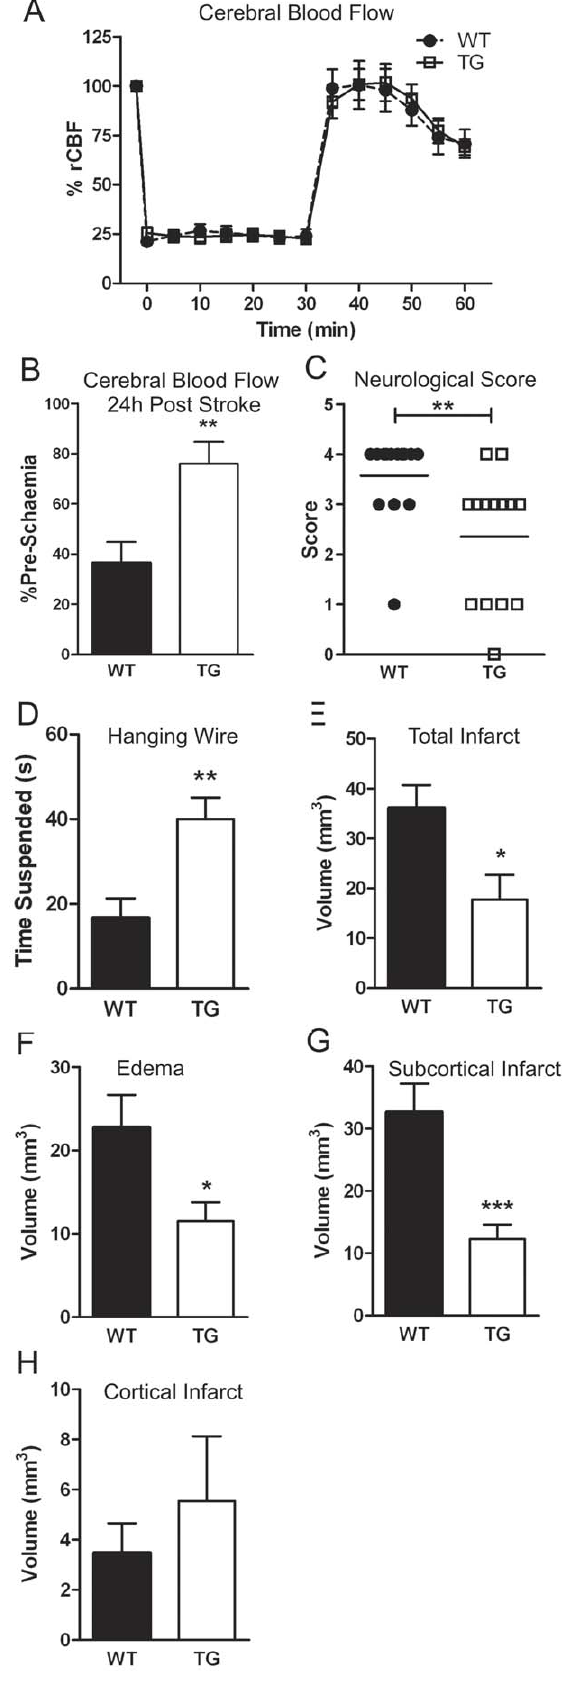
Figure 1. Over-expression of DSCR1 underlies an improved outcome following stroke. WT (black symbols and bars, n=14) and DSCR1-TG (white symbols and bars, n=14) mice were subjected to stroke. Regional cerebral blood flow (rCBF) was recorded during and for 0.5 h after stroke (A) and at 24 h (B), and expressed as a percentage of the pre-ischemic value. Compared with WT, DSCR1-TG mice had an improved neurological deficit score (C) and better performance in a hanging wire grip test (D). Total infarct (E) and edema (F) volumes were also smaller after stroke in DSCR1-TG than WT mice. DSCR1-TG mice had smaller subcortical (G) but not cortical (H) infarcts. Neurological scores are presented as median, and all other data are presented as mean 6 SEM; *P , 0.05, **P , 0.01, ***P ,